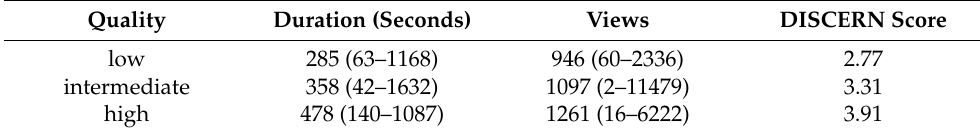
Table 4. The GQS groups compared to other parameters.